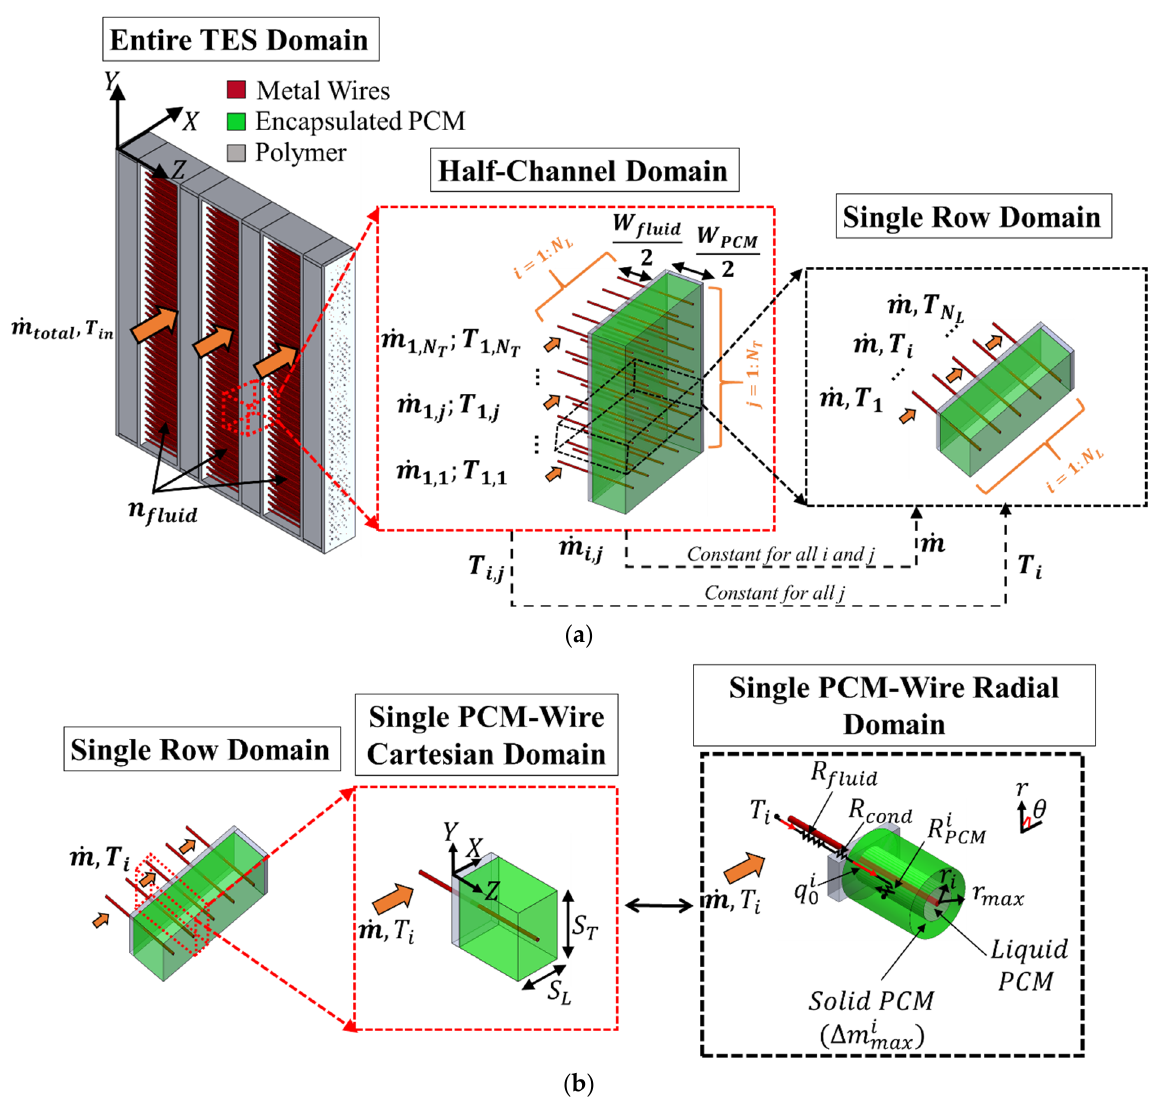
Figure 2. Domain simplification: ( a ) entire TES domain to single ‐ row domain; ( b ) single ‐ row domain to single ‐ wire radial domain.